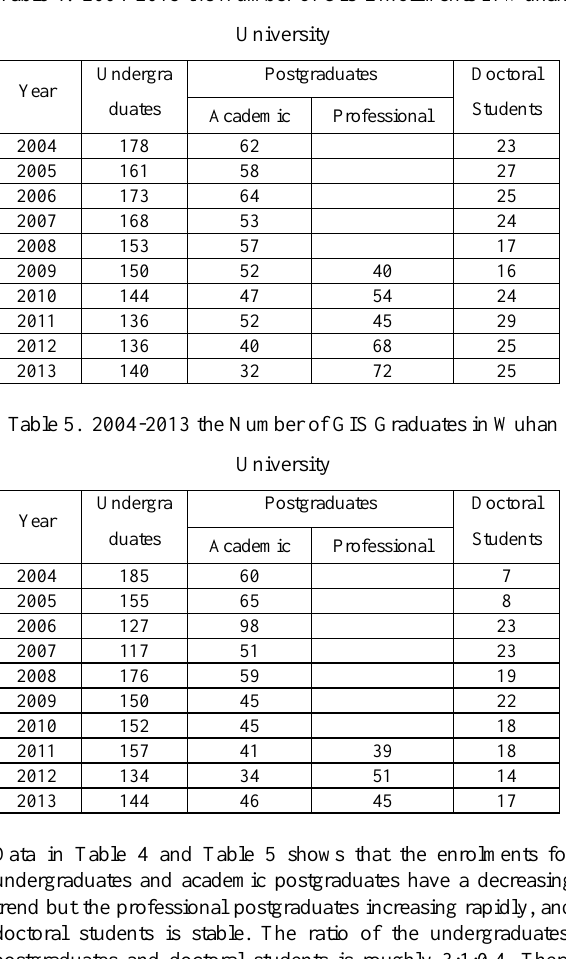
Table 4. 2004-2013 the Number of GIS Enrollments in Wuhan